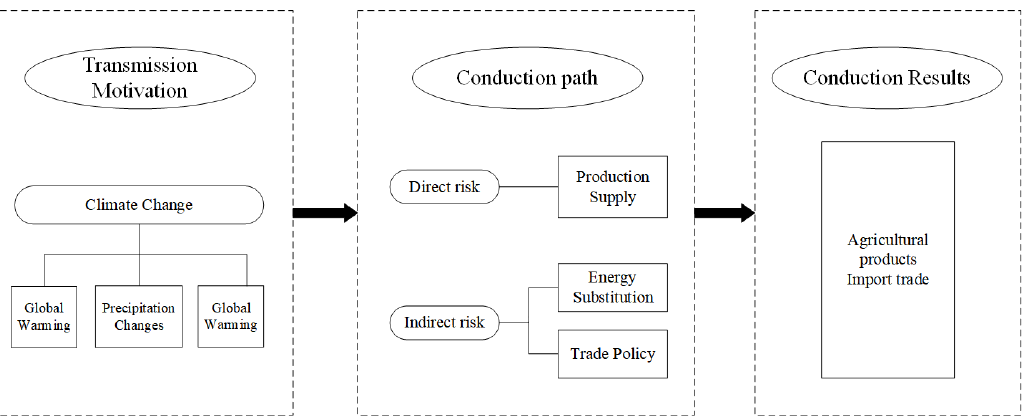
Figure 1. Theoretical analysis model of the impact of climate change on China’s agricultural import trade.